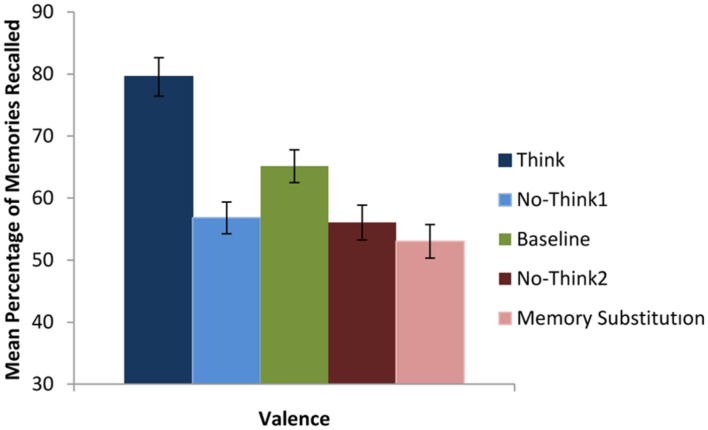
Mean percentage of memories recalled as a function of instruction type. Error bars represent ±1 standard errors of the mean (SEM).